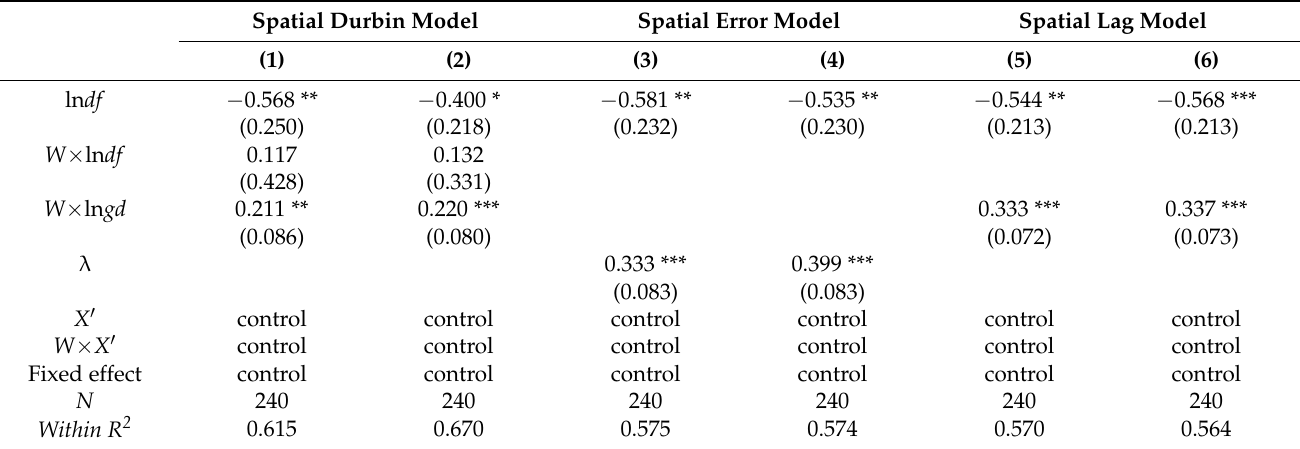
Table 4. Estimated results of the spatial econometrics for the digital finance and green